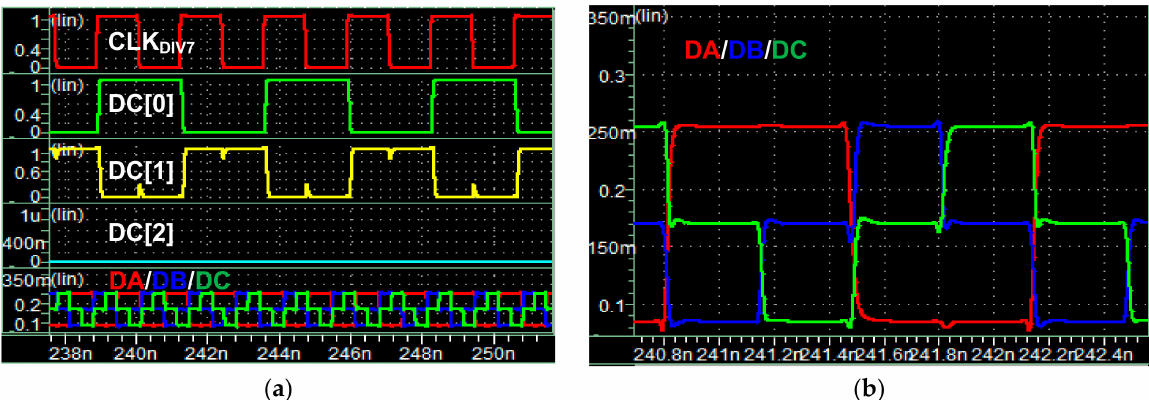
Figure 6. Simulation results of pre-determined data generator and MIPI C-PHY transmitter: ( a ) Waveforms of DC signals and DA/DB/DC signals; ( b ) Magnified waveforms of DA/DB/DC